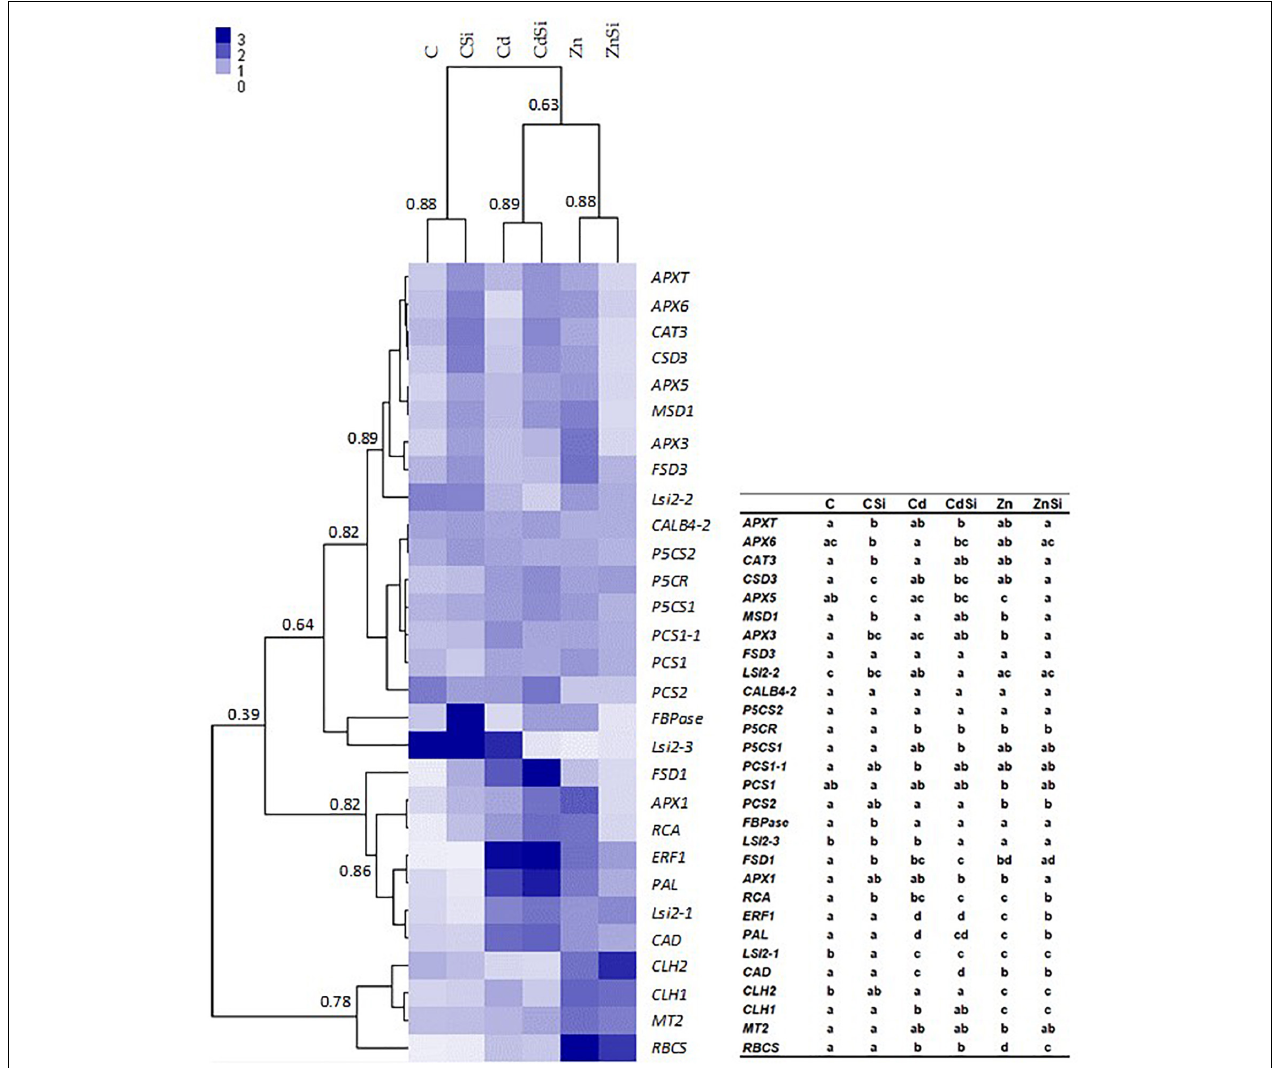
FIGURE 3 | Heatmap hierarchical clustering showing the expression of genes assessed by quantitative reverse transcription PCR (RT-qPCR) in the leaves of hemp plants. Plants were exposed for 1 week to Cd (20 µ M) or Zn (100 µ M) in the presence or absence of Si (2 mM) (C: control plants not exposed to HM). Values represent normalized relative quantities (NRQs). For each group, the Pearson coefficient is provided. The table represents statistical analyses of the heatmap hierarchical clustering. The different letters indicate that the values are significantly different from each other ( p < 0.05; Tukey’s HSD all-pairwise